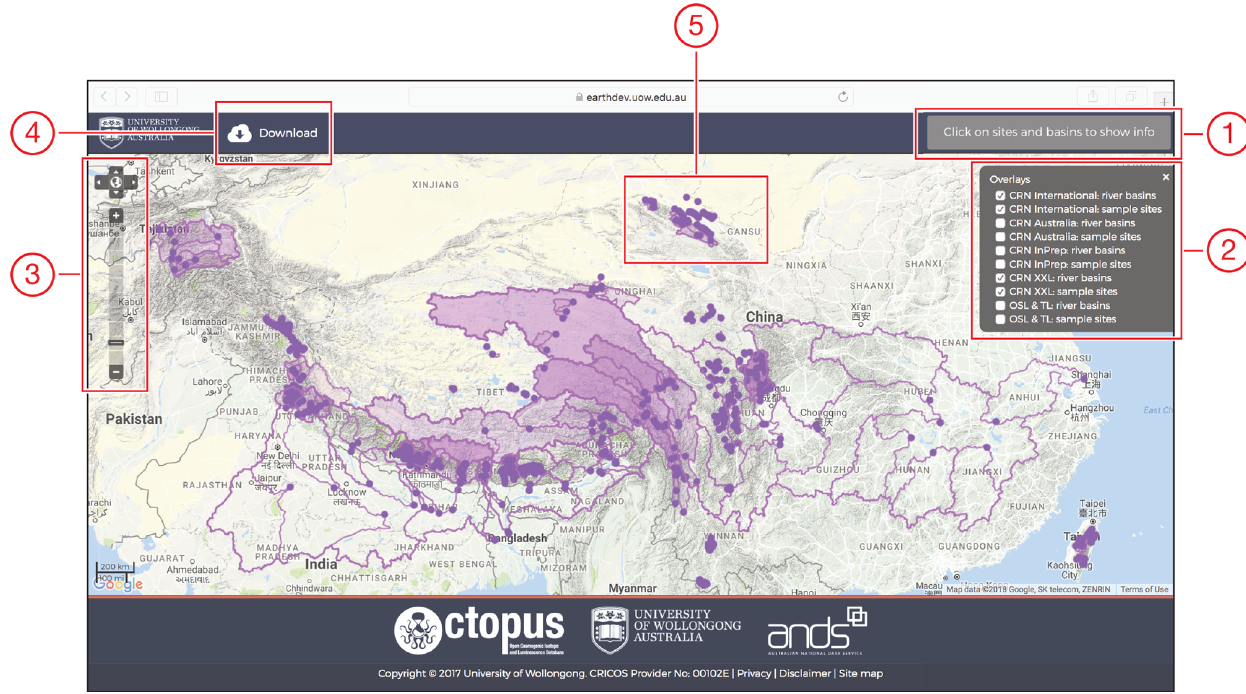
Figure 2. The OCTOPUS web interface with main elements: (1) message box that provides the user with step-by-step help on how to navigate the web page, (2) collapsible panel with a list of all available data layers, (3) navigation buttons, (4) data download button, (5) Google Terrain base map and point and polygon data layers. See text for more